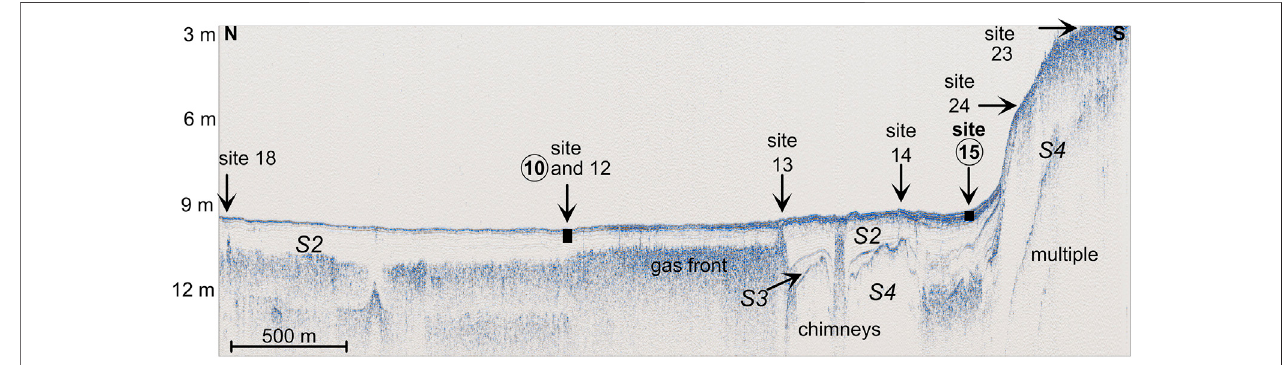
FIGURE 10 | Sediment acoustic pro fi le of the western N-S transect in WB. The cores are represented as a circle around the site number, and the length of each core is indicated by the black bar.